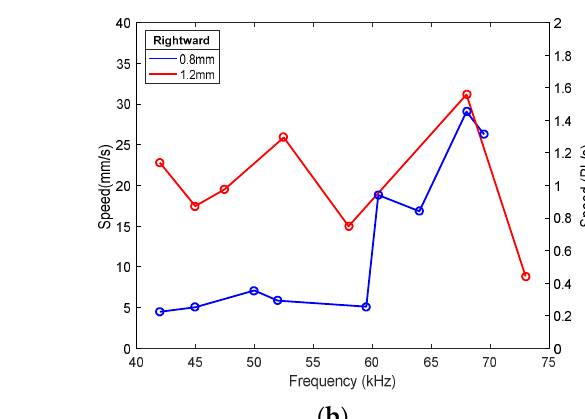
( b ) Figure 7. Simulated ( a ) displacement and ( b ) speed of the trajectory of the tip of the legs situated at the left side of the robot, for both the high-order and the low-order combinations.